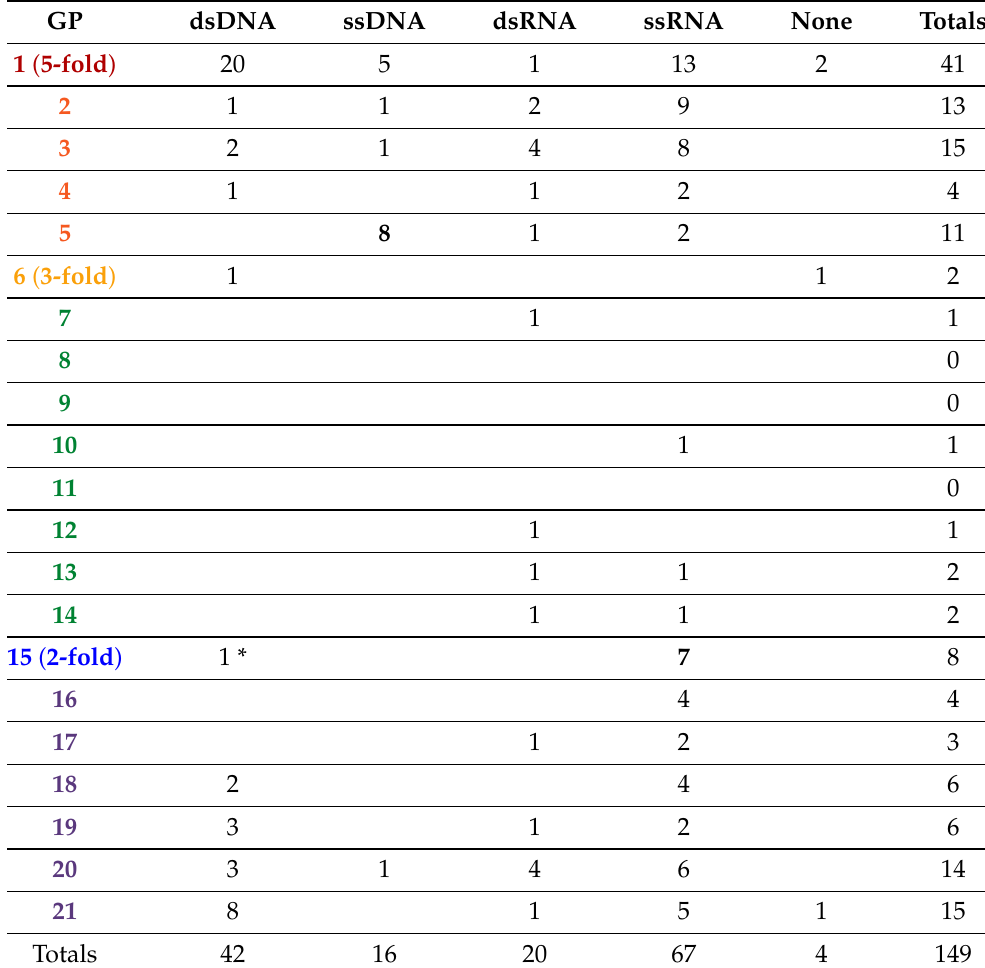
Table 4. Gauge Points of Protruding Features vs. Genome. The genomic compositions of the 149 structural protrusions of the 135 distinct capsids found in the VIPERdb [1]. We found that only RNA viruses are found to have protrusions from gauge point 7 to 17, which we refer to as the “T” region; see Figure 6. There is one notable exception, the aberrant T3 form of HBV (*), which is too small to actually encapsulate its DNA genome [32,33]. We also see that RNA capsids protrusions dominate GP 2 ( 85% ) , GP 3 ( 80% ) and GP 20 ( 71% ) . Capsids with ssDNA are also clearly dominant at GP 5 ( 73% )